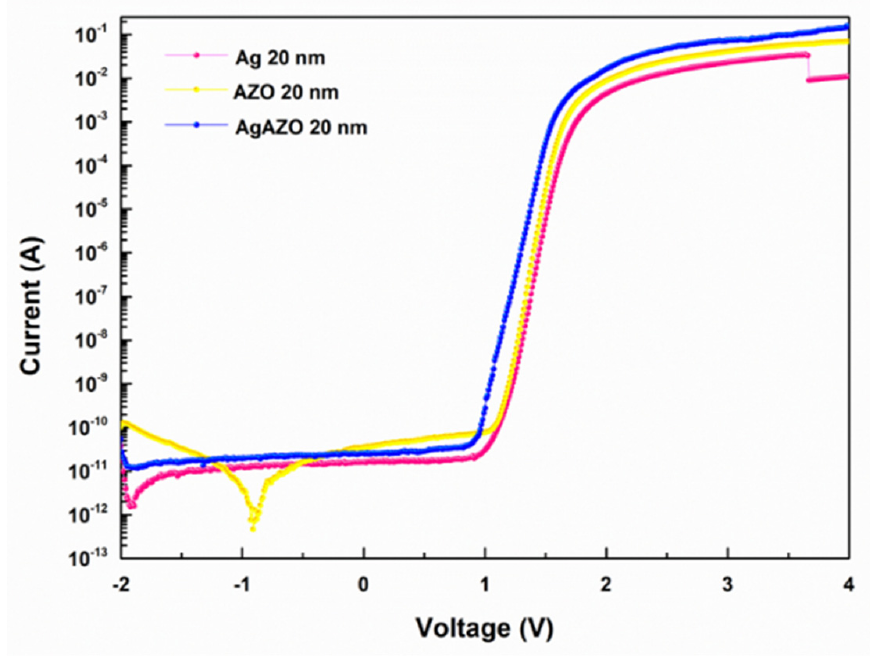
Figure 7. Electrical parameters of the photodetector as a function of Ag:AZO thickness.